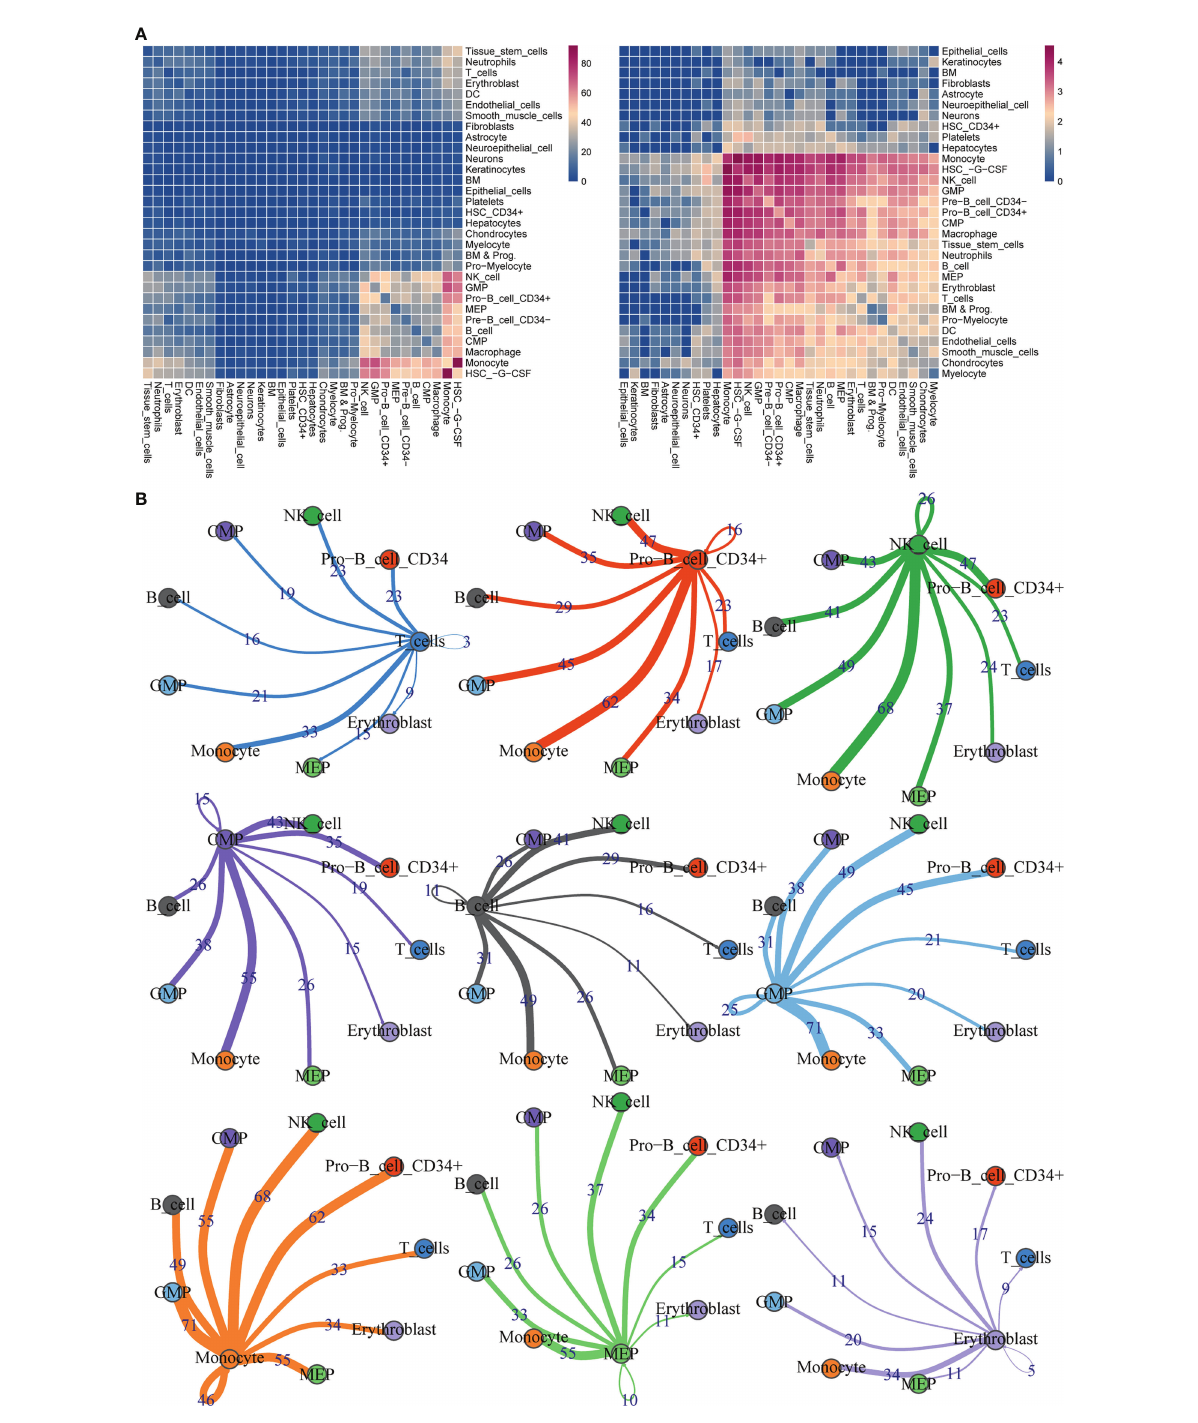
FIGURE 5 Ligand-receptor interaction predictions between 9 cell types. (A) Heatmaps of ligand – receptor interactions by CellphoneDB analysis. (B) Visualization of interaction pairs with p value <= 0.05 and log2 mean (Molecule 1, Molecule 2) >=